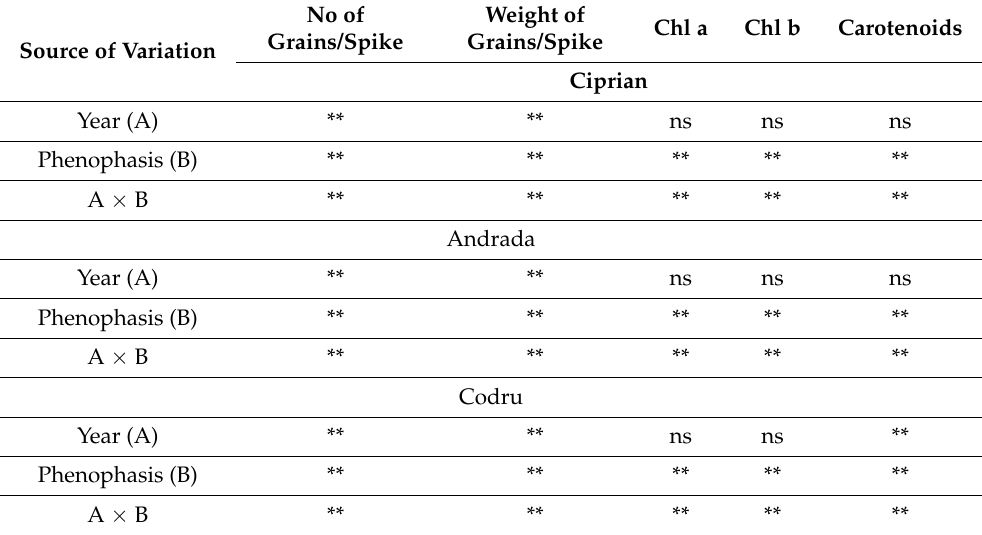
Table 1. ANOVA and significance of F test for the main yield components and photosynthetic pigments as a result of removed flag